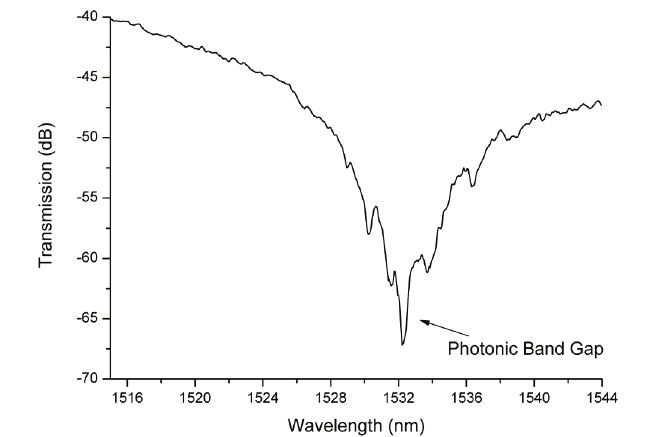
Figure 4. Transmission spectrum of a reference ethanol solution (96.00%) pumped into a microfluidic channel with an 18 pillar array. The 27 dB loss observed at 1532.312 nm corresponds to a convoluted loss of the several modes propagating in the waveguide and not to a specific mode band gap of the